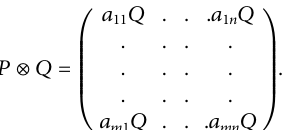
FIGURE 1 Example of base graph